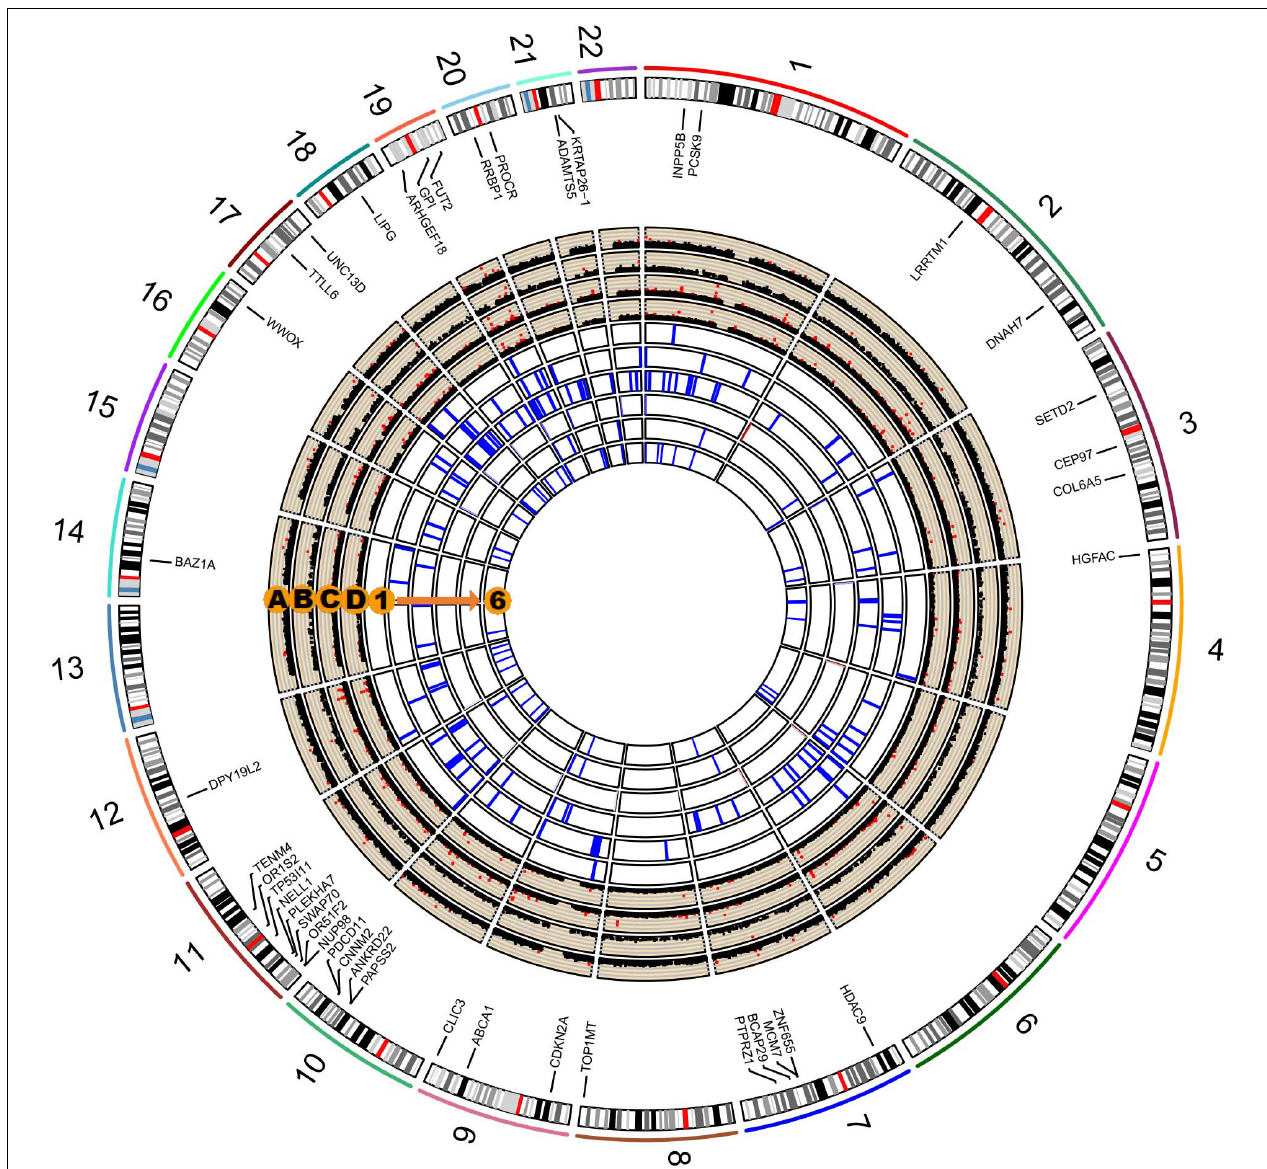
FIGURE 2 | Circos plot integrating the results of single-variant, gene-based, and pathway-based analysis. The labeled genes are those significantly associated with ACS in both our study and in the existing in silico meta-GWAS dataset. Circos Manhattan plots of single-variant and gene-based analysis in our study participants (A and B); Circos Manhattan plots of single-variant and gene-based analysis in the meta-GWAS dataset (C and D). The six most significant pathways identified in our dataset and validated by the meta-GWAS dataset: (1) GO cyclin dependent protein serine threonine kinase inhibitor activity; (2) KEGG RIG-I-like receptor signaling pathway; (3) GO organophosphate ester transport; (4) GO negative regulation of muscle cell differentiation; (5) GO phospholipid efflux; (6) GO phospholipid